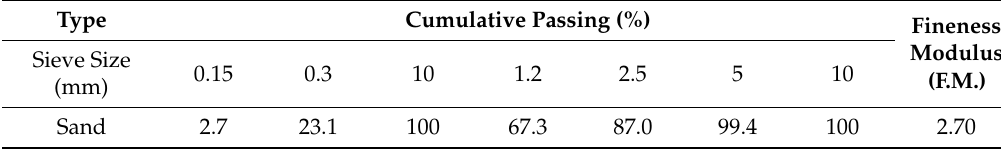
Table 4. Sieve analysis test of